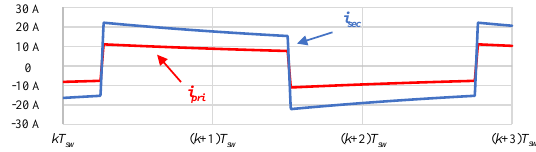
Figure 7. Current waveforms in the primary and secondary sides of the HF transformer using SPS modulation.